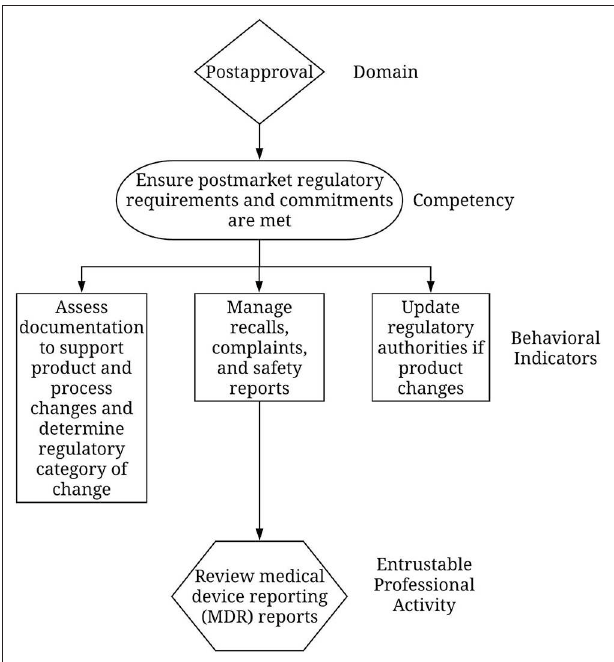
FIGURE 1 | Example of competency-behavioral indicator-EPA relationship.